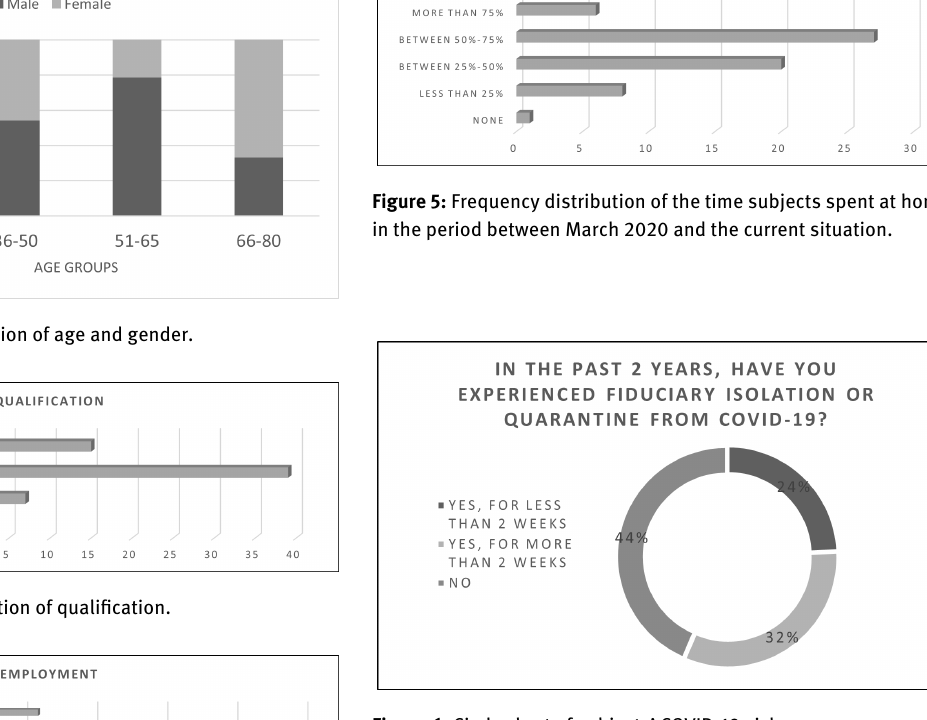
Figure 6: Circle chart of subjects’ COVID-19